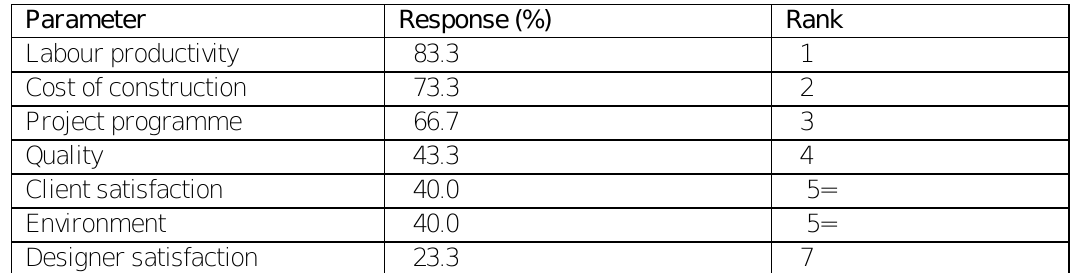
Table 7: Extent to which inadequate or the lack of health and safety negatively affects other project